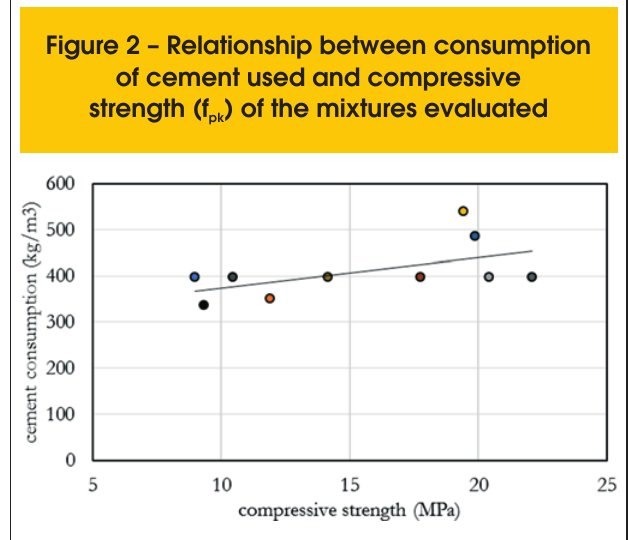
Figure 2 – Relationship between consumption of cement used and compressive strength (f ) of the mixtures evaluated pk